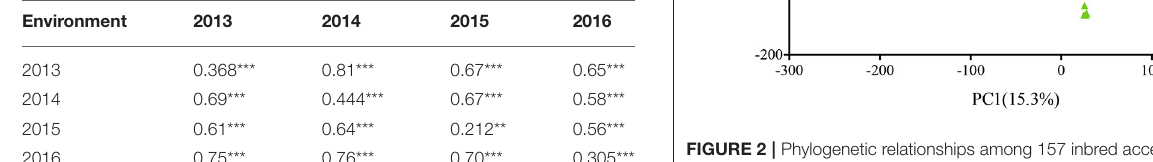
TABLE 2 | Correlation of silique weight (SW) and silique length (SL).